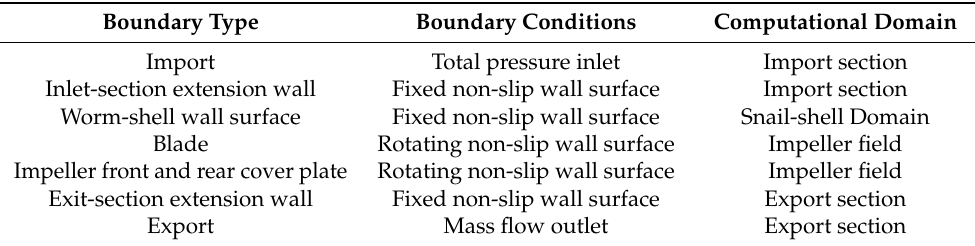
Table 2. Boundary condition setting of the computational